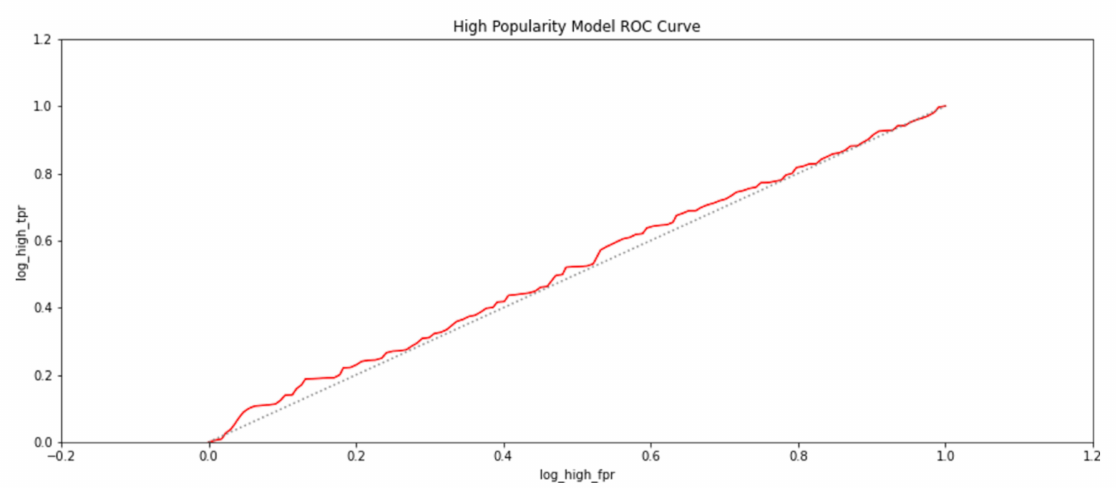
Figure 15. The probability of an exhibit area being in a highly popular category as identified by a logistic regression- based